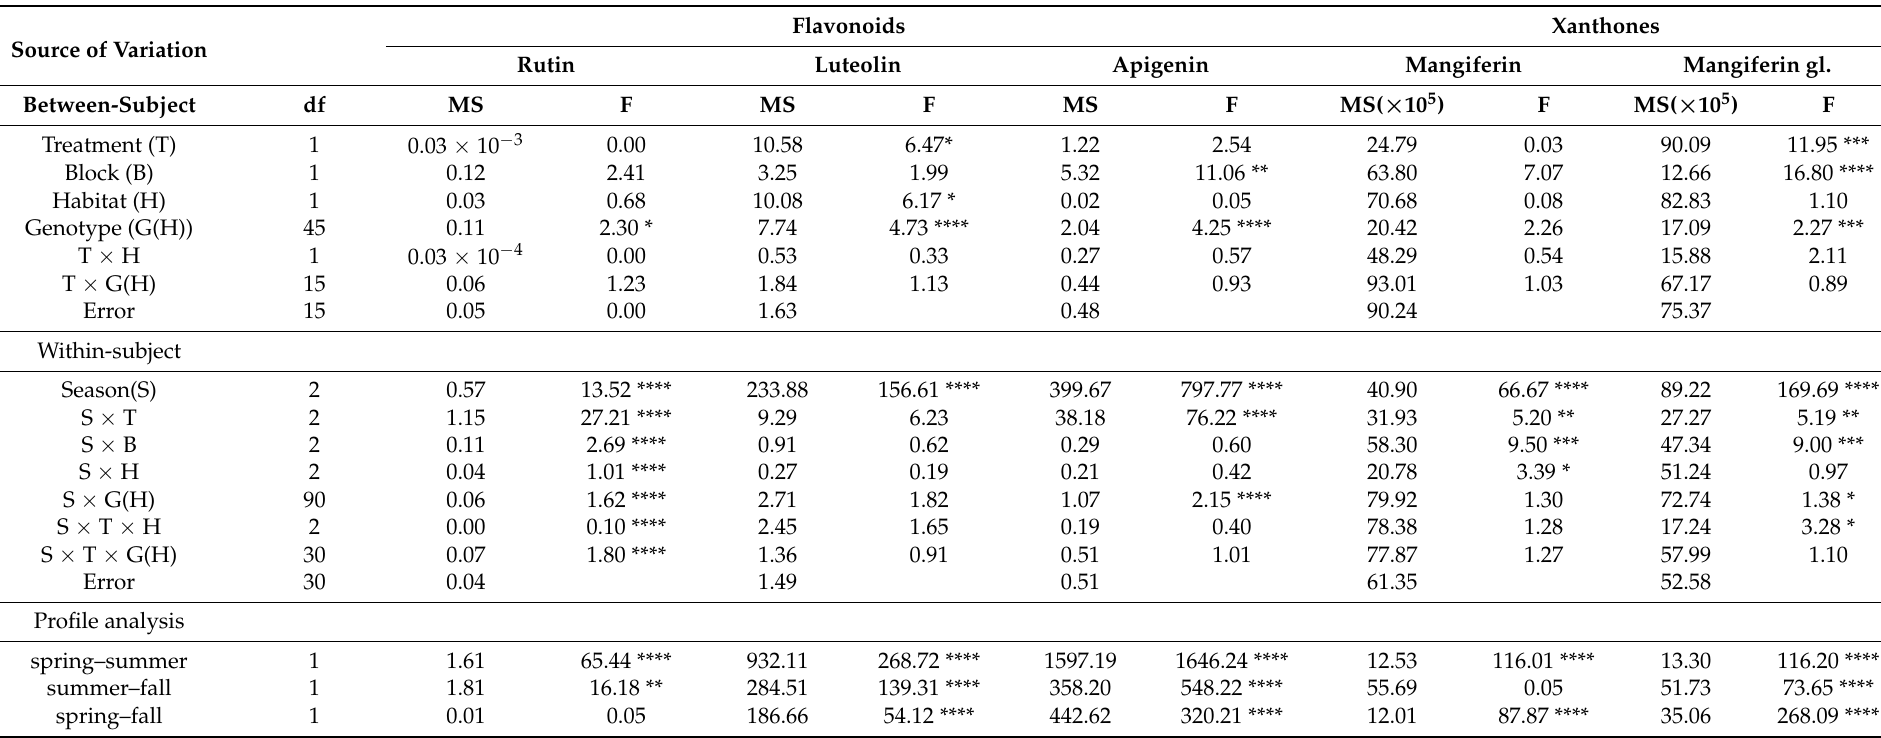
Table 1. Repeated measure analysis of variance (RM ANOVA) and PROFILE analysis for Iris variegata leaf secondary metabolites: phenolic acids (caffeic acid and chlorogenic acid), flavonoids (naringenin, naringin, quercetin, rutin, luteolin and apigenin) and xanthones (mangiferin and mangiferin glucoside) in genotypes from contrasting light habitats (sun-exposed and shaded), under two light treatments (low and high) and observed across seasons (spring, summer, fall) in one experimental year. Flavonoids Xanthones Source of Variation Rutin Luteolin Apigenin Mangiferin Mangiferin